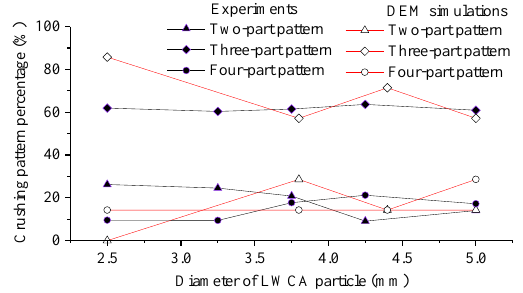
Fig. 8. Percentages of three crushing modes.